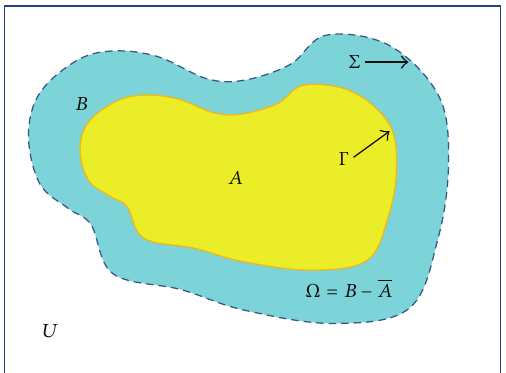
Figure 1: The exterior Bernoulli free boundary problem.